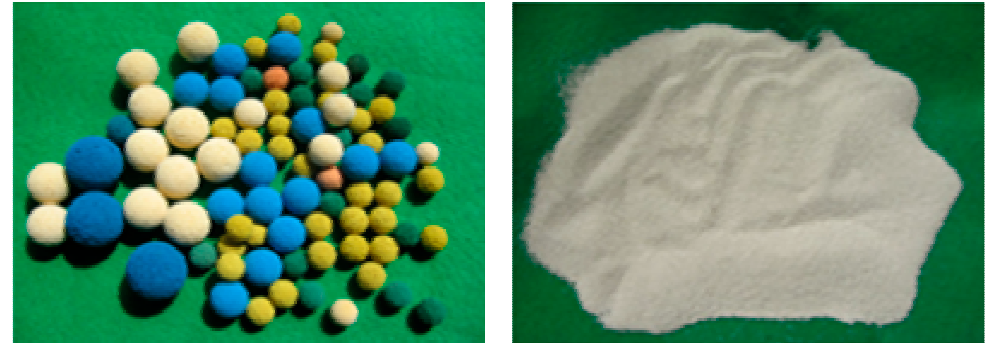
Figure 2. Sponge and ceramic balls for the automatic fouling cleaning system.